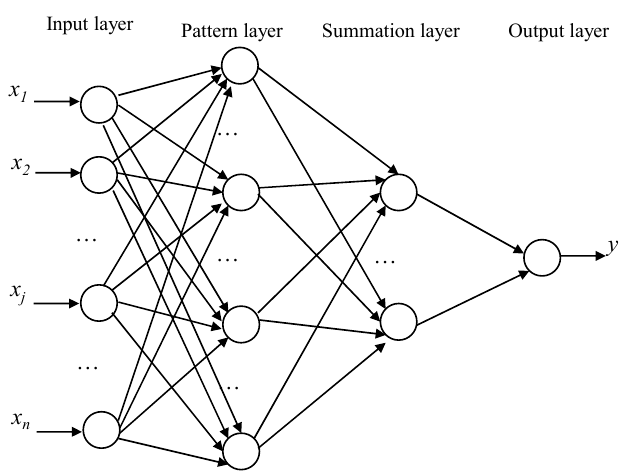
Figure A1. General regression neural networks (GRNN) with multi-input-one-output architecture. The inputs x i (i = 1, . . . , n ) are shown in Table 2, and the output y represents R n